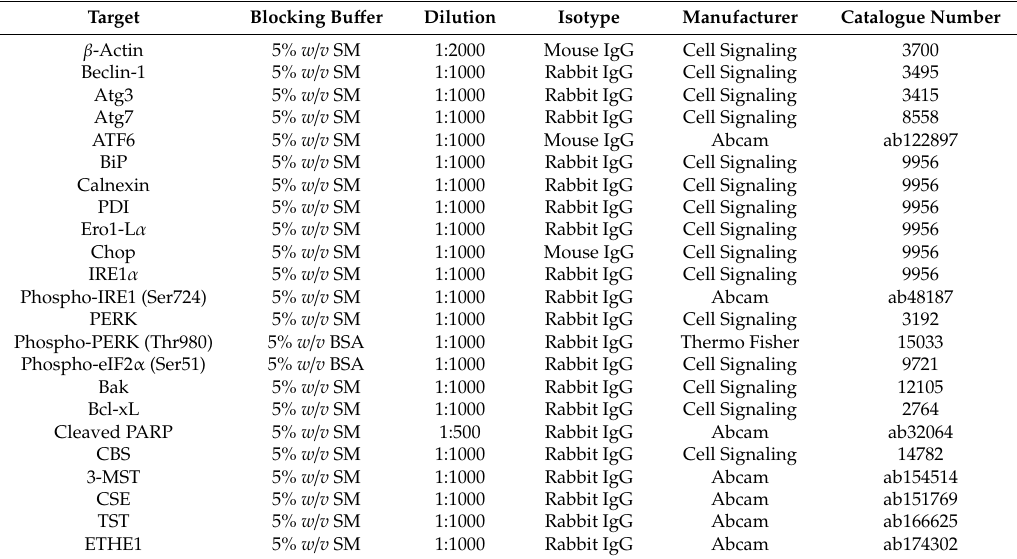
Table 1. List of primary antibodies used in Western blotting. (SM = skimmed milk; BSA: bovine serum